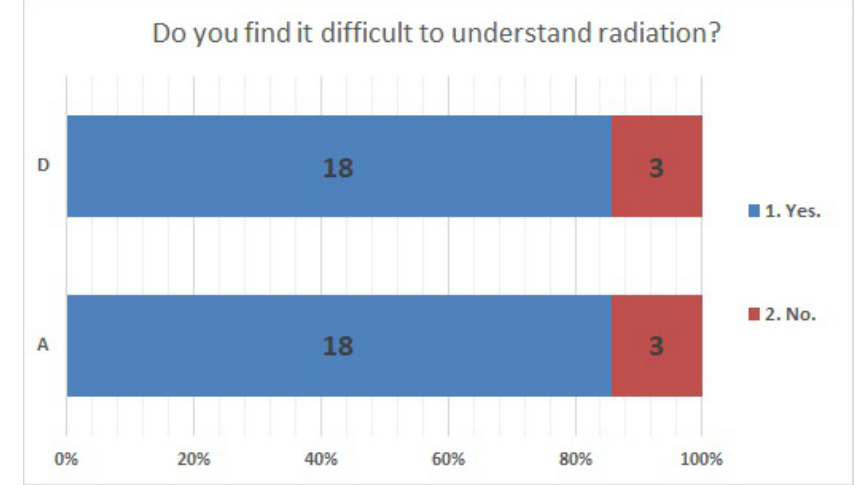
Figure 6. Responses to item No. 41.